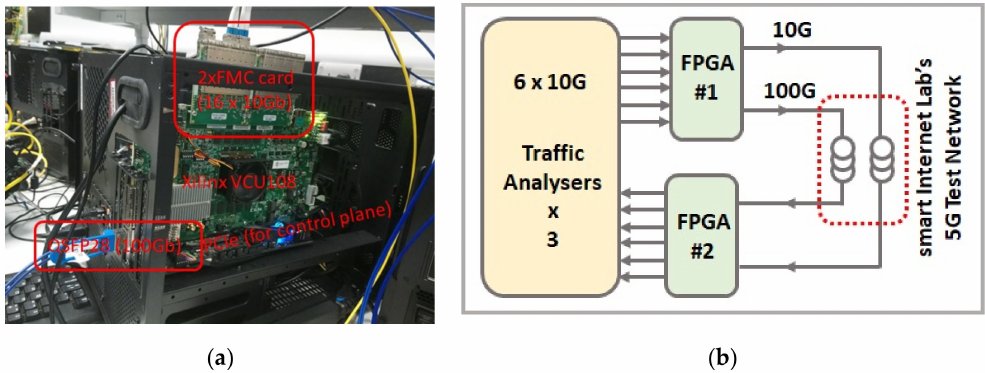
Figure 13. Testbed setup: ( a ) TSON edge node; ( b ) the TSON edge nodes testbed setup architecture.